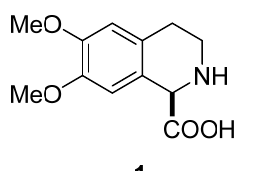
Figure 2. (–)-6,7-Dimethoxy-1,2,3,4-tetrahydroisoquinoline-1-carboxylic acid ( 1 ).